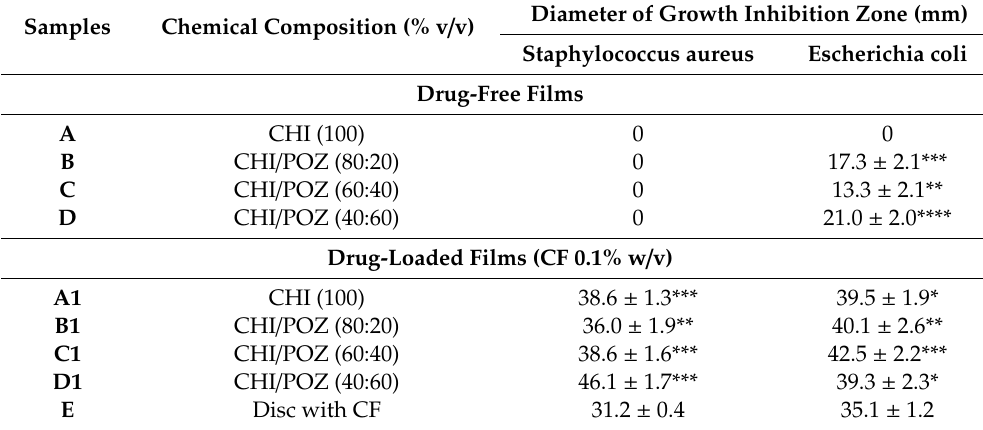
Table 2. Antimicrobial activity of CHI and CHI / POZ blend